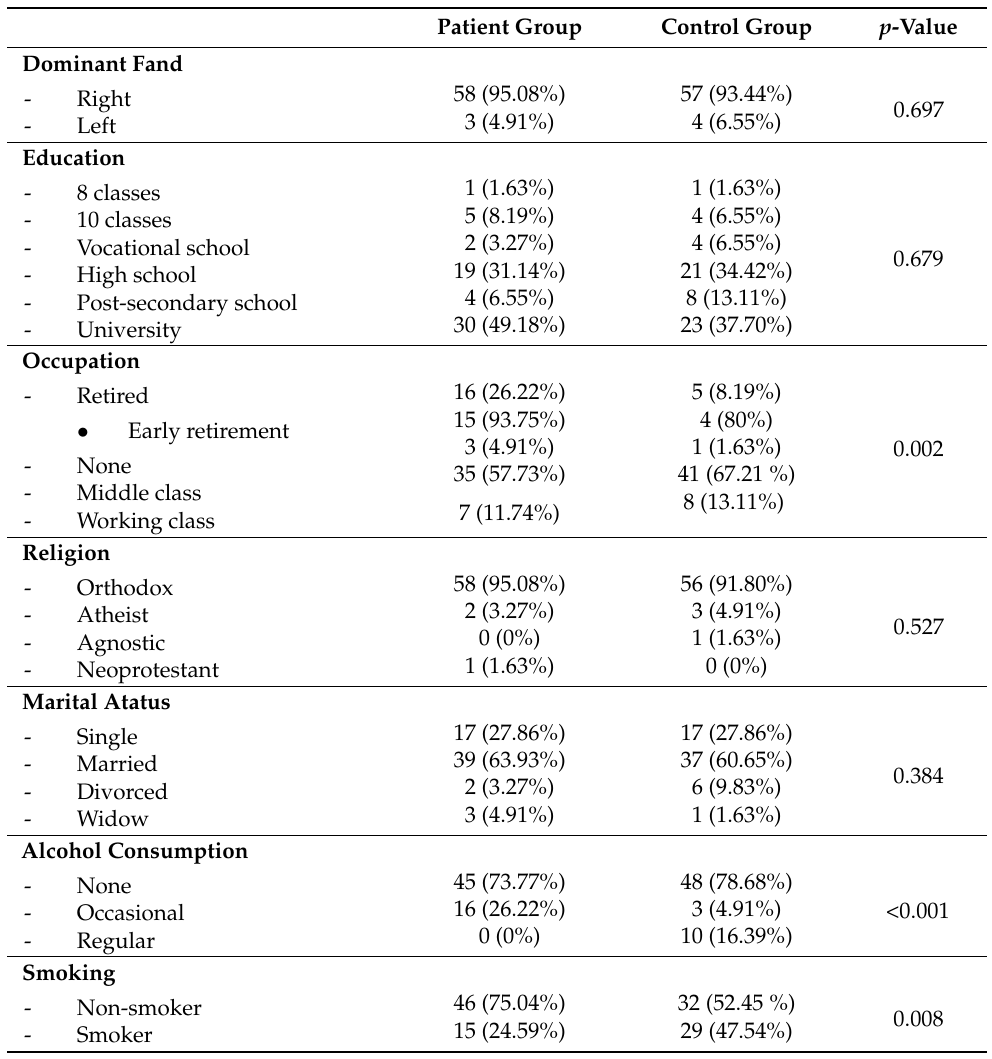
Table 1. Demographic parameters.